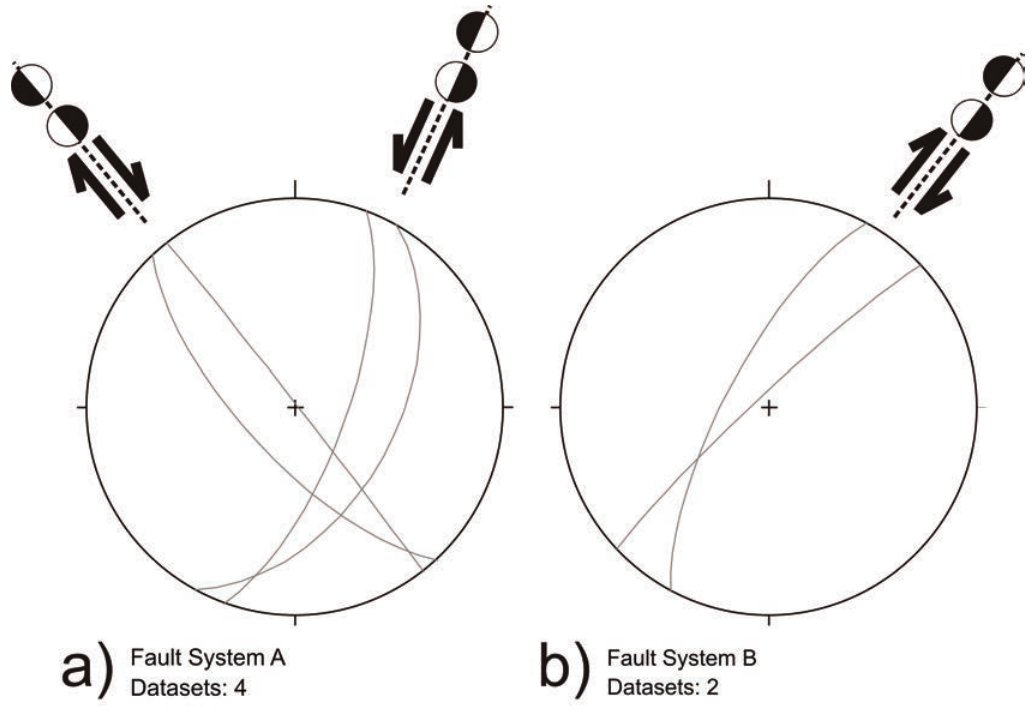
Figure 11. Stereographic plot of the two main fault systems (lower hemisphere; Schmidt net – β diagram): a) system A - NW-SE to NNW- SSE faults, with normal-dextral oblique slip, conjugate of NNE-SSW to NE-SW normal-left lateral structures; b) system B - NNE-SSW to NE-SW faults with normal-dextral oblique slip. TectonicsFP software® [Ortner et al.